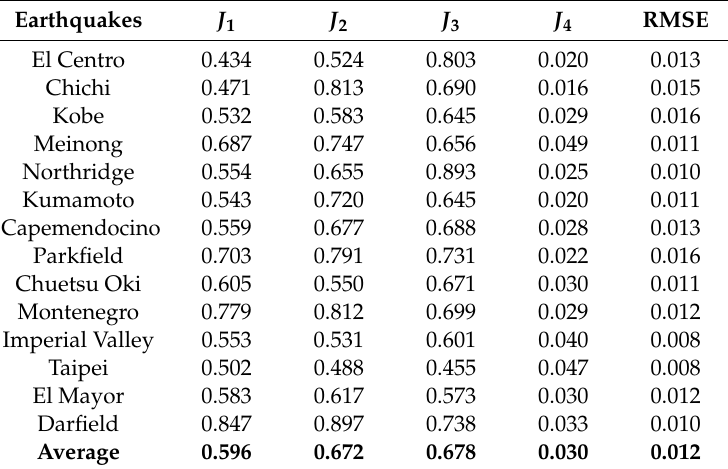
Table 6. Seismic control performance of the MLP-200.